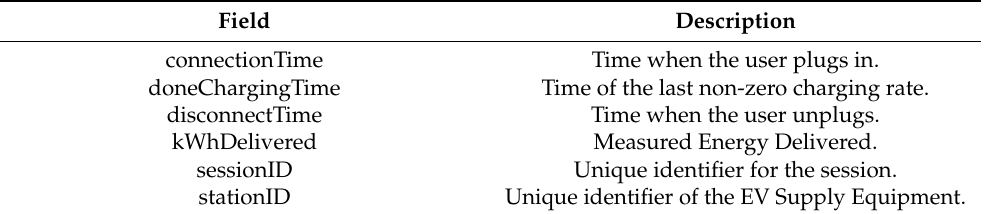
Table 1. Part of data fields in ACN-Data. Field Description connectionTime Time when the user plugs in. doneChargingTime Time of the last non-zero charging rate. disconnectTime Time when the user unplugs. kWhDelivered Measured Energy Delivered. sessionID Unique identifier for the session. stationID Unique identifier of the EV Supply